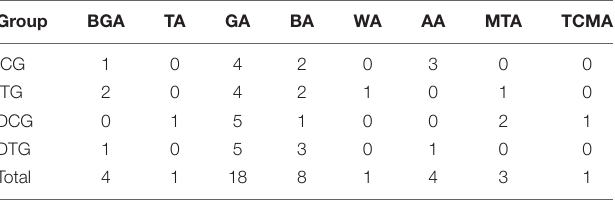
TABLE 2 | Types of aphasia in the four study